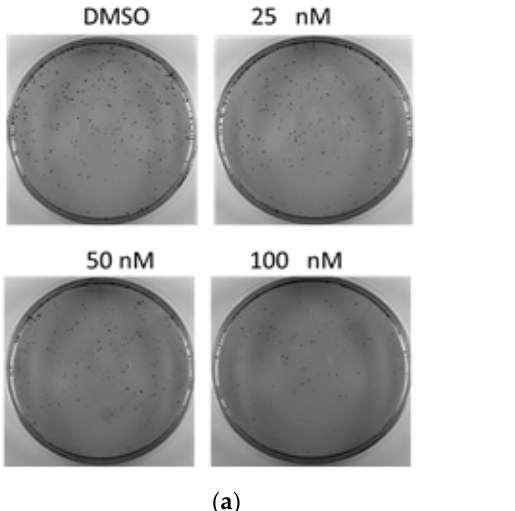
were treated with vehicle (DMSO) or SKD. After 24 h, a colony formation assay was performed as